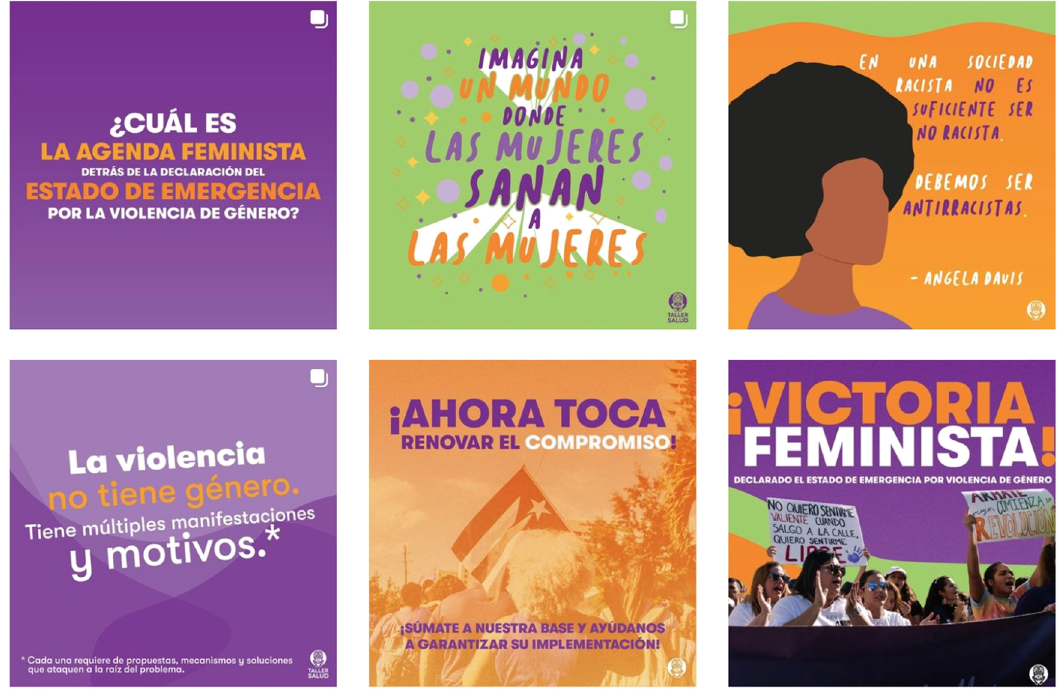
Figure 4: Screenshot from Taller Salud Instagram Page.